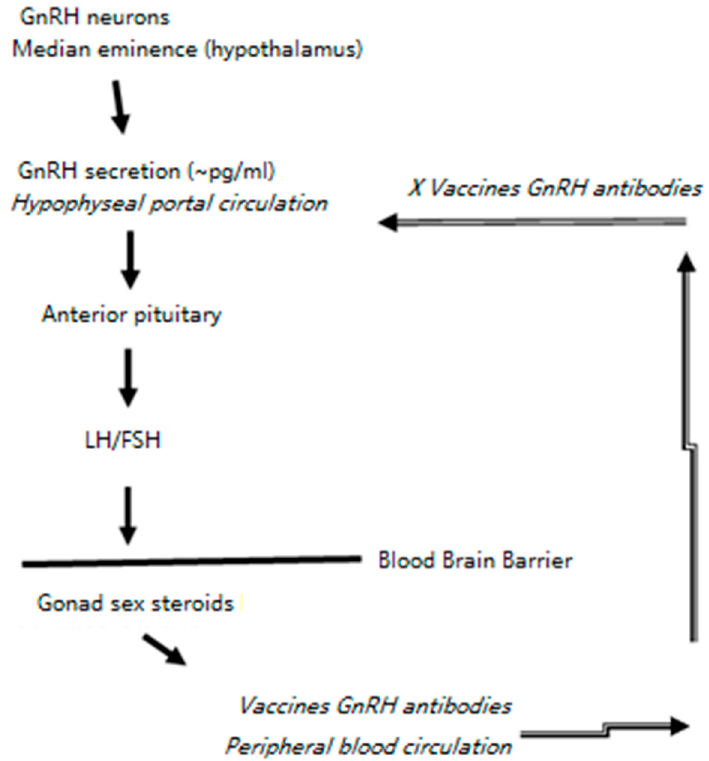
Figure 5. Mechanism of GnRH-based antibodies on contraception. GnRH neurons in hypothalamus secrete GnRH to the hypophyseal portal system (HPS). Free GnRH in the HPS stimulates the release